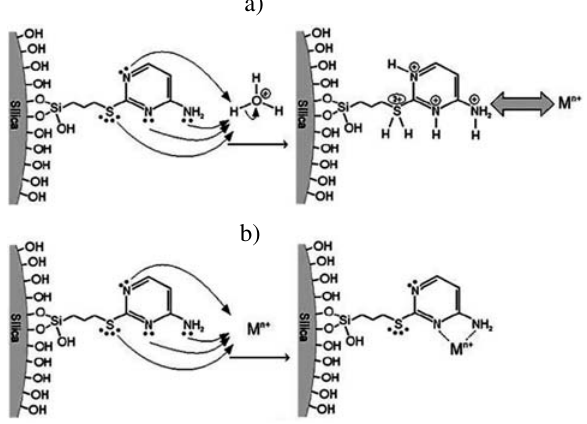
Figure 7. Protonation of the material’s adsorption sites (a) and the coordination of a metal species (M n+ ) to an adsorption site. The gray arrow in (a) represents the repulsive force between the free ca- tion and the protonated